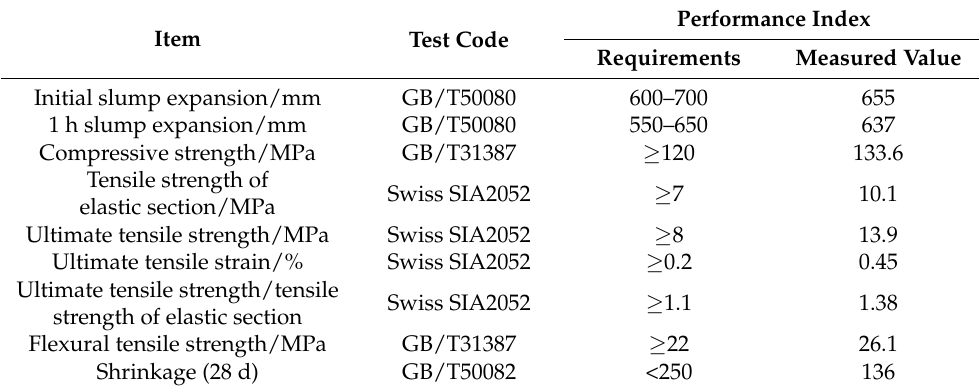
Table 1. Technical parameters of UHPC for pavement.